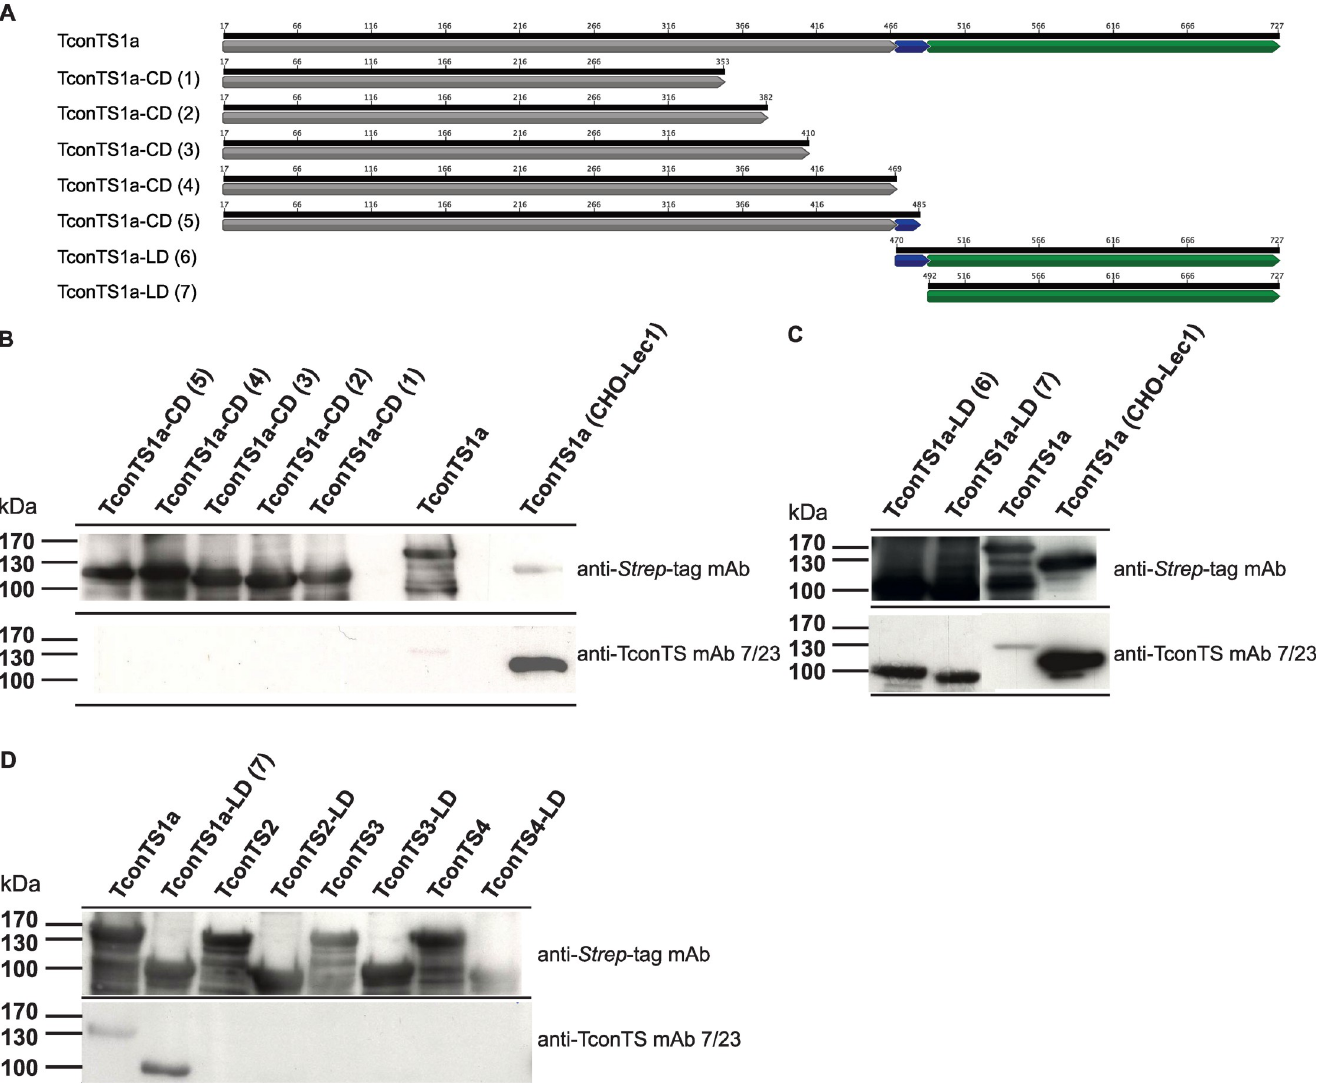
Fig 5. Epitope mapping of anti-TconTS mAb 7/23 binding epitope. A: Schematic presentation of wild type and truncated TconTS1a constructs (1–5, CD: catalytic domain, 6–7 LD: lectin domain) used for anti-TconTS mAb 7/23 epitope mapping. Structural elements, such as catalytic domain (CD), α -helix and lectin domain (LD) are labelled in grey, blue and green respectively. B-D: Western blot analysis of TconTS1a constructs (1–7) using anti-TconTS mAb 7/23 and anti- Strep -tag mAb as indicated (details under Methods). All TconTS1a constructs were expressed in E . coli Rosetta pLacI and bacterial lysates were used for SDS polyacrylamide gel electrophorese. 100 ng TconTS1a expressed and purified from CHO-Lec1 cells was used as a control in Western blot experiments.